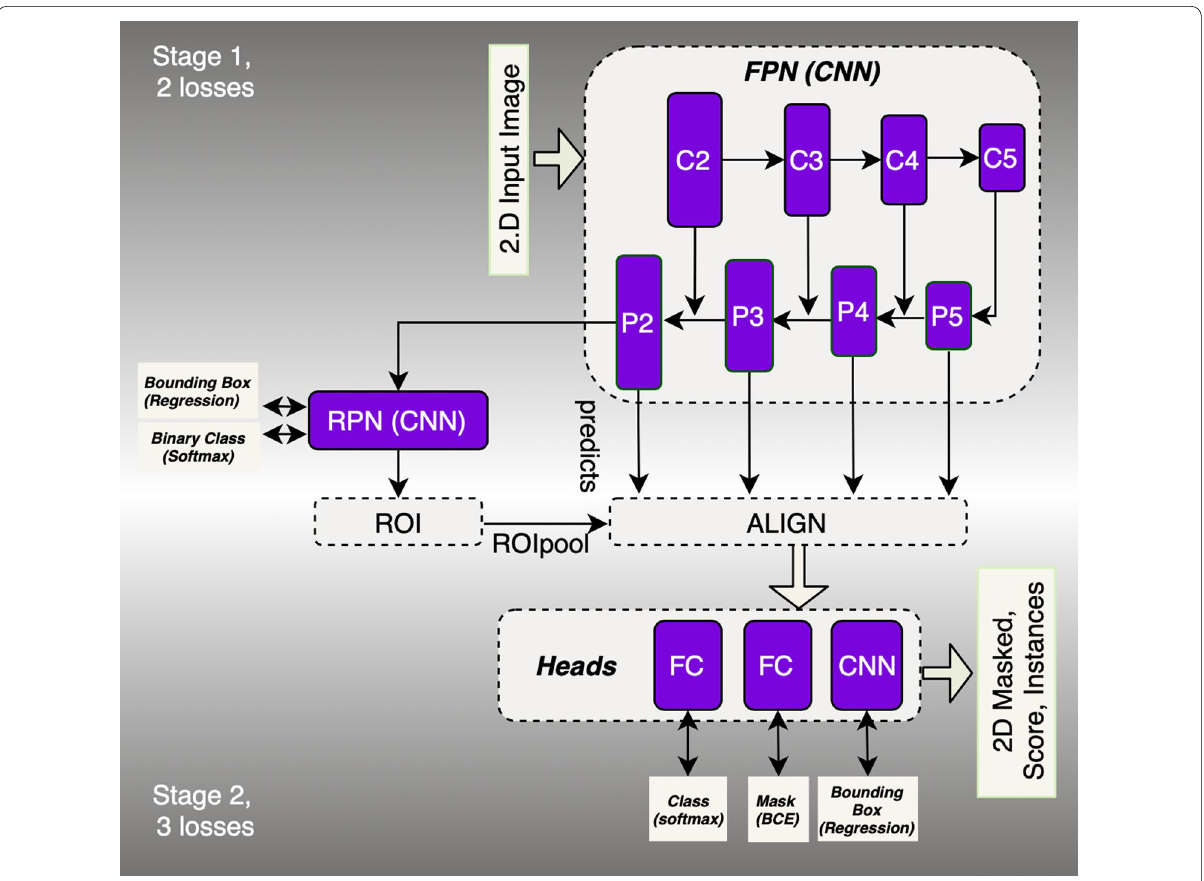
Fig. 1 Mask‑rcnn structure consists of two stages. The object of interest in the input image is artificially wrapped into boxes, binary‑classified and fine‑tuned. These boxes are then fed into the second stage of the network to be further fine‑tuned to better fit the area where the object is located and multi‑classified. Pixels inside the best box are then binary‑classified to generate the mask. In this image, RPN stands for regional proposal network, FPN stands for feature pyramid network, RoI for region of interest and ALIGN is the RoI‑Align mechanism. The head section is where 3 separate networks (two FCs, i.e. fully connected neural network and one CNN) generate the output. The rectangular boxes connected to the RPN box and Heads box indicate the type of loss functions. C and P represent the CNN layers used to construct the bottom‑up and top‑down architecture of the FPN respectively